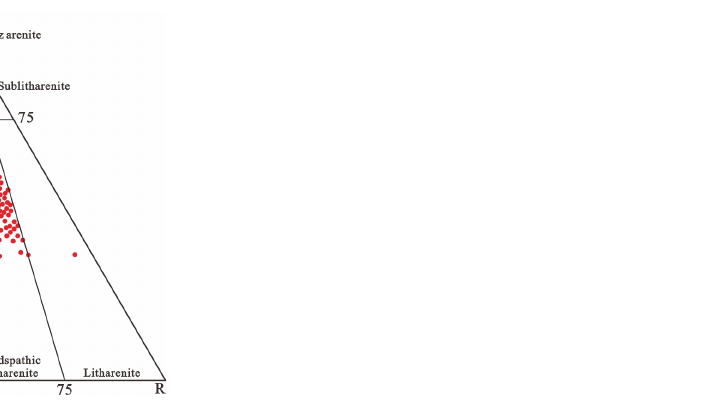
Figure 2. Ternary diagram showing the framework grain composition of the Chang-7 Member sandstones in the Ordos Basin [37].